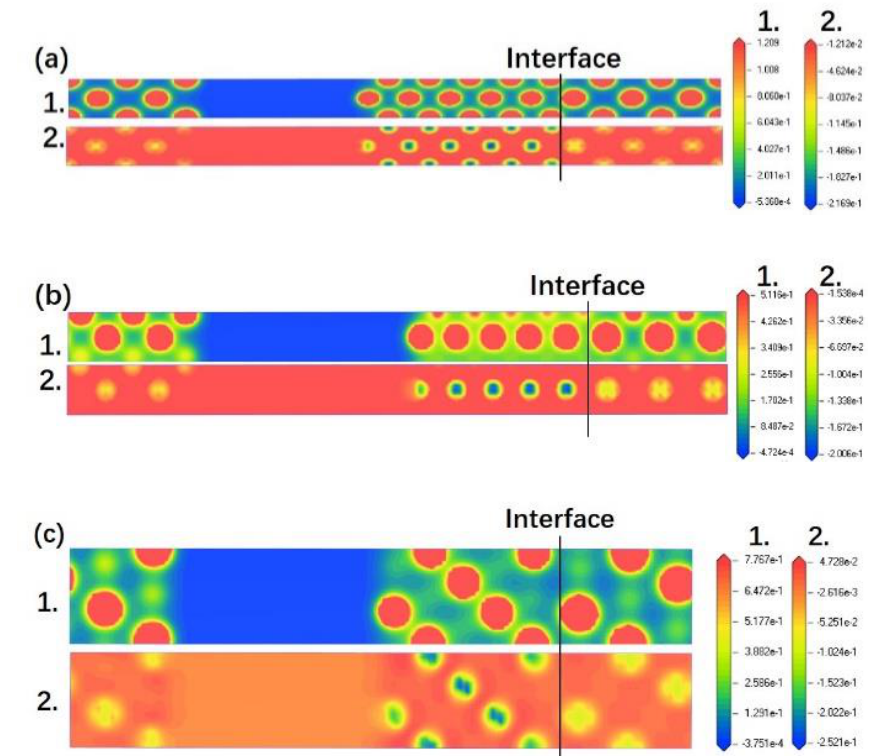
Figure 4. The charge density distribution and the difference charge density distribution of the interface. ( a ) Ag(100)/Cu(100); ( b ) Ag(110)/Cu(110); ( c ) Ag(111)/Cu(111).